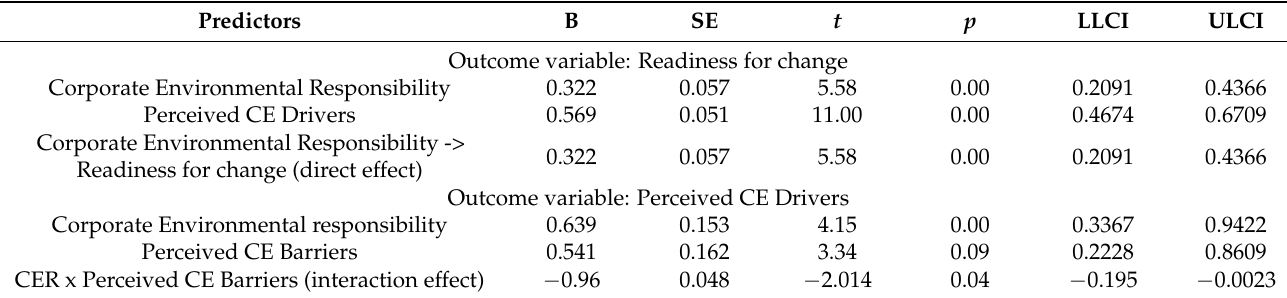
Table 3. The Moderated Mediation